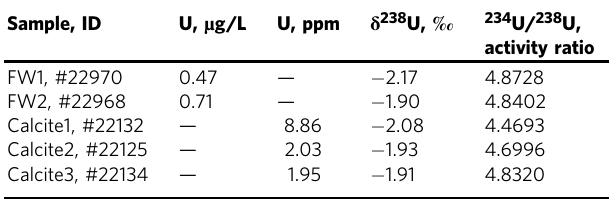
Table 2 U content, δ 238 U and 234 U/ 238 U measured in calcite and fracture water (FW) samples, collected from borehole sections at Äspö